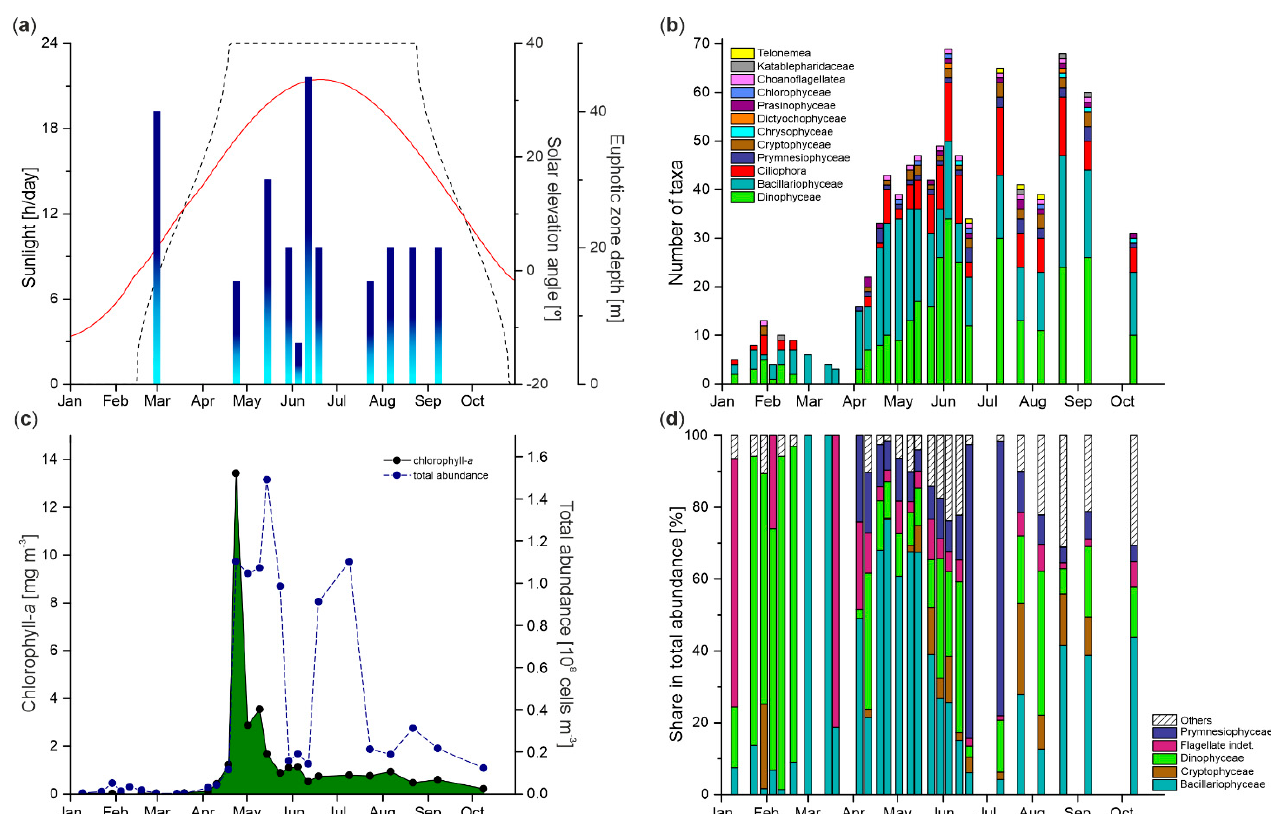
Figure 4. ( a ) Hours [h] of sunlight (black dashed line) and solar elevation angle [°] per day (solid orange line) (in both cases, data were sourced from https://www.unis.no/resources/weather-stations/; accessed on 10 March 2021), and depth of the euphotic zone [m] (gradient fill bars); ( b ) the total number of protists taxa (the groups were presented on bars in order from largest to smallest share in the total number of taxa; for groups with the same number of taxa, alphabetical order was applied); ( c ) chlorophyll- a concentrations [mg m − 3 ] (green-covered area) and total protist abundance [10 8 cells m − 3 ] (blue dashed line); ( d ) percent contribution of major groups to the total abundance at the IsA station during the investigated period.